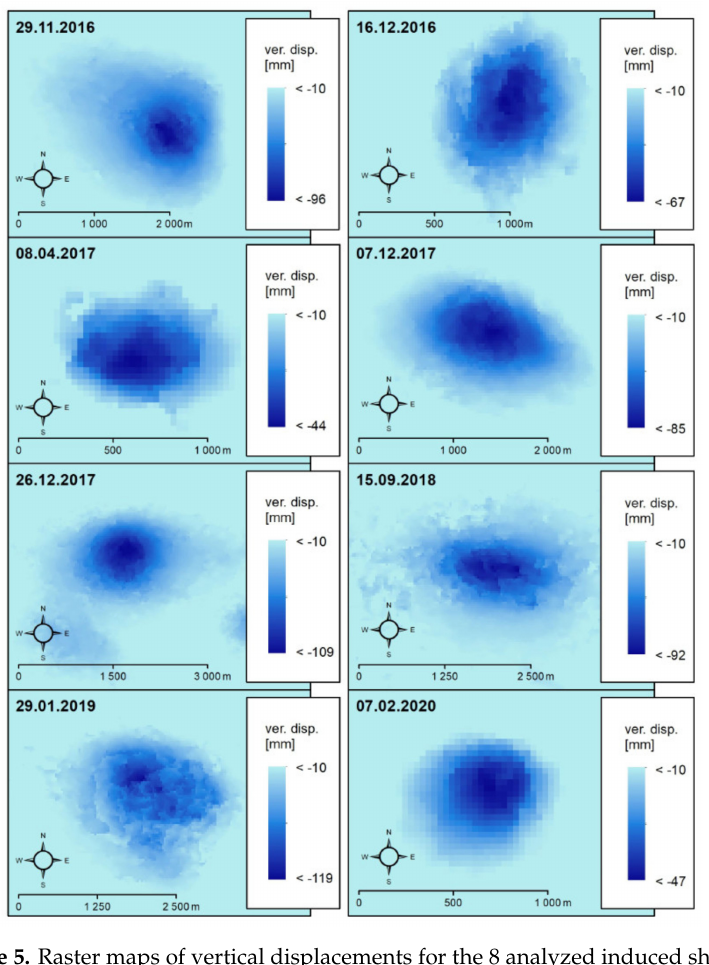
Figure 5. Raster maps of vertical displacements for the 8 analyzed induced shocks.